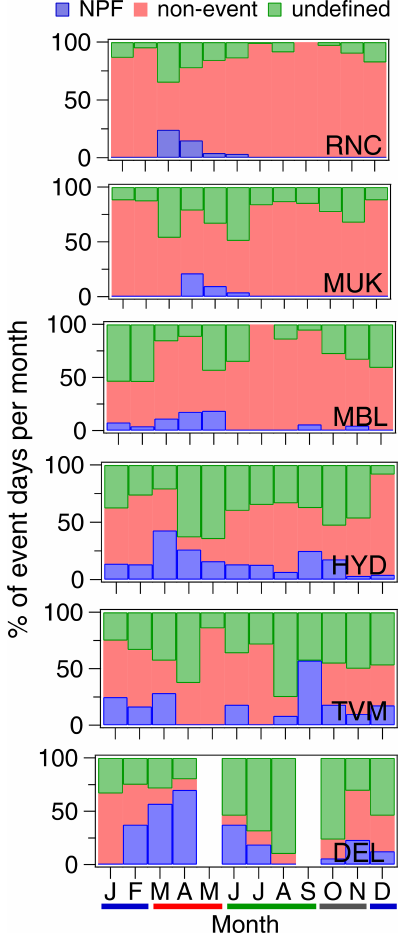
Figure 8. Monthly percentage of occurrence of NPF, non-event, and undefined events days based on total valid observations days at all the sites. The thick blue, red, green, and gray lines indicate win- ter, pre-monsoon, monsoon, and post-monsoon months. Note that measurements are from different time periods for each site (see Ta- ble